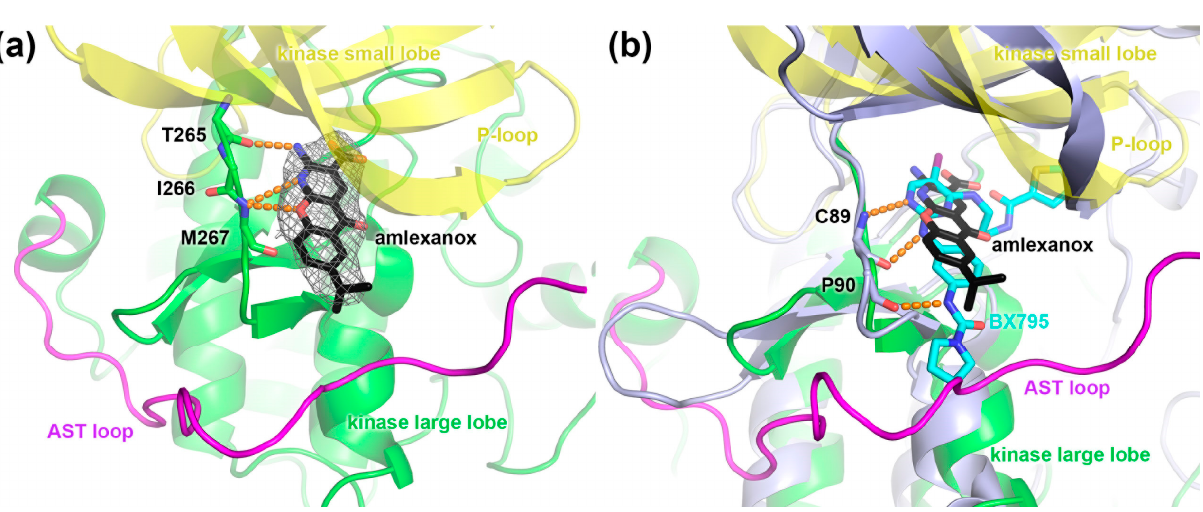
Figure 4. Crystal structure of GRK1 bound to amlexanox. ( a ) Amlexanox (stick model with black carbons) forms several hydrogen bonds (orange dashed lines) with the hinge of the GRK1 kinase domain (large lobe green and small lobe yellow). The isopropyl group of amlexanox is oriented to form hydrophobic interactions with the AST loop (magenta). Grey mesh corresponds to a 3 σ | F o |-| F c | omit map. ( b ) Superposition of the kinase domain of GRK1 with that of TBK1 in complex with BX795 (cyan carbons) (PDB entry 4EUT, light blue) suggest that modifications to the amlexanox scaffold that fill the ribose and polyphosphate subsites of the active site, such as the thiophene arm of BX795, or that optimize contacts with the AST loop are routes to increase potency and/or